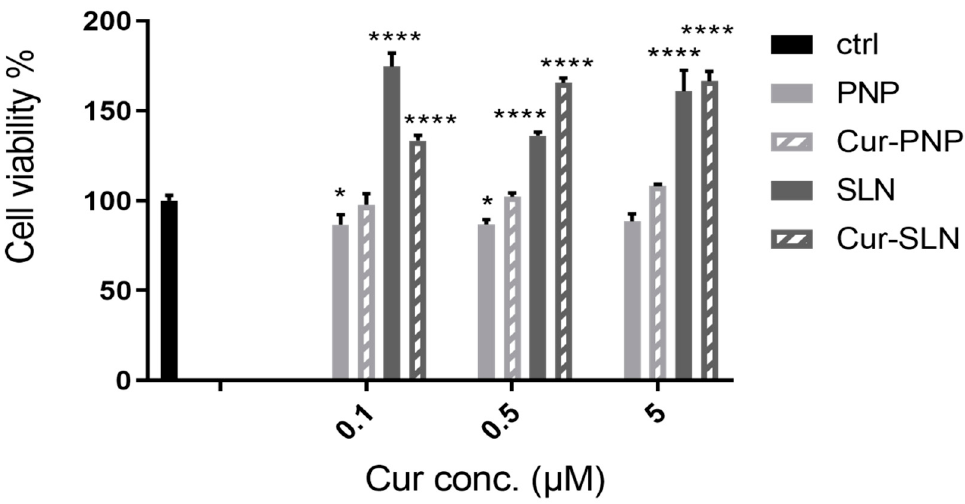
Figure 3. Cell viability after exposure for 24 h of normal olfactory ensheathing cells (OECs) to Cur-PNP and Cur-SLN at different concentrations. Significance was defined as * p < 0.05; **** p <